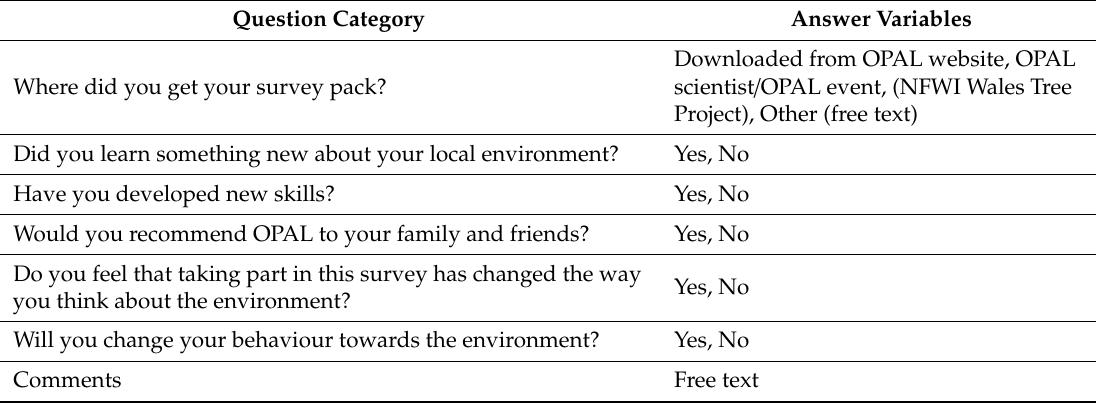
Table 6. Evaluation